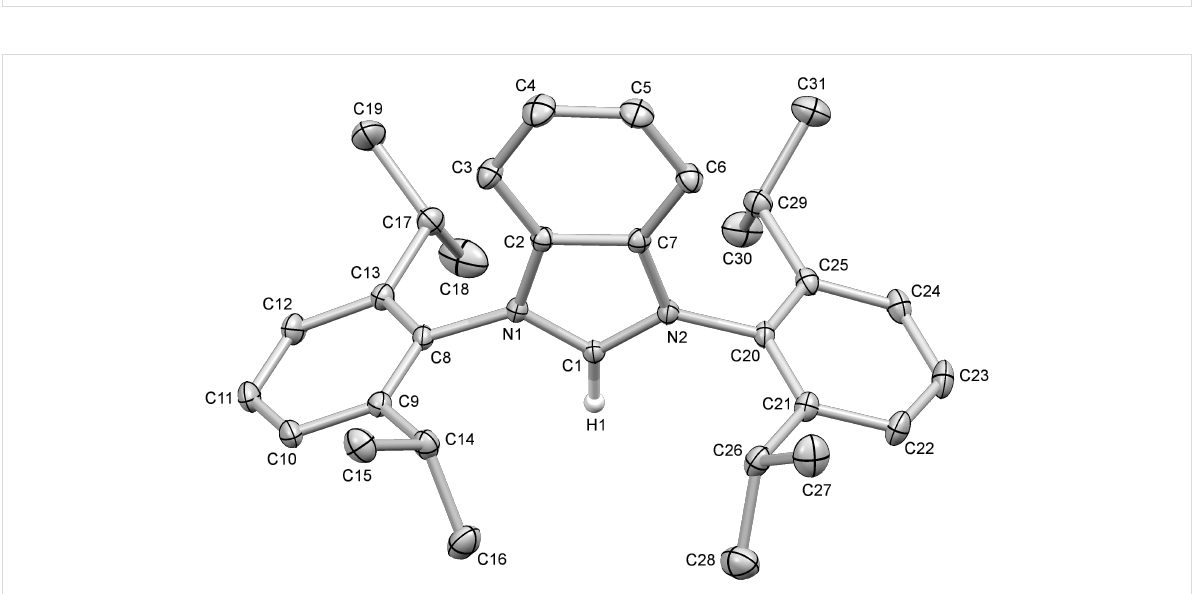
Figure 3: Molecular structure of 2 -Cl. The solvate molecule, the counterion and the hydrogen atoms are omitted for clarity. The displacement ellip- soids are drawn at the 30% probability. Selected bond lengths (Å) and angles (°): N2–C1–N1 109.3(2), N2–C1–H1 126.1(17), N1–C1–H1 124.6(17), N1–C1 1.334(3), N2–C1 1.330(3), N1–C2 1.392(3), N2–C7 1.397(3), N1–C8 1.448(3), N2–C20 1.447(3), C1–H1 0.97(3).